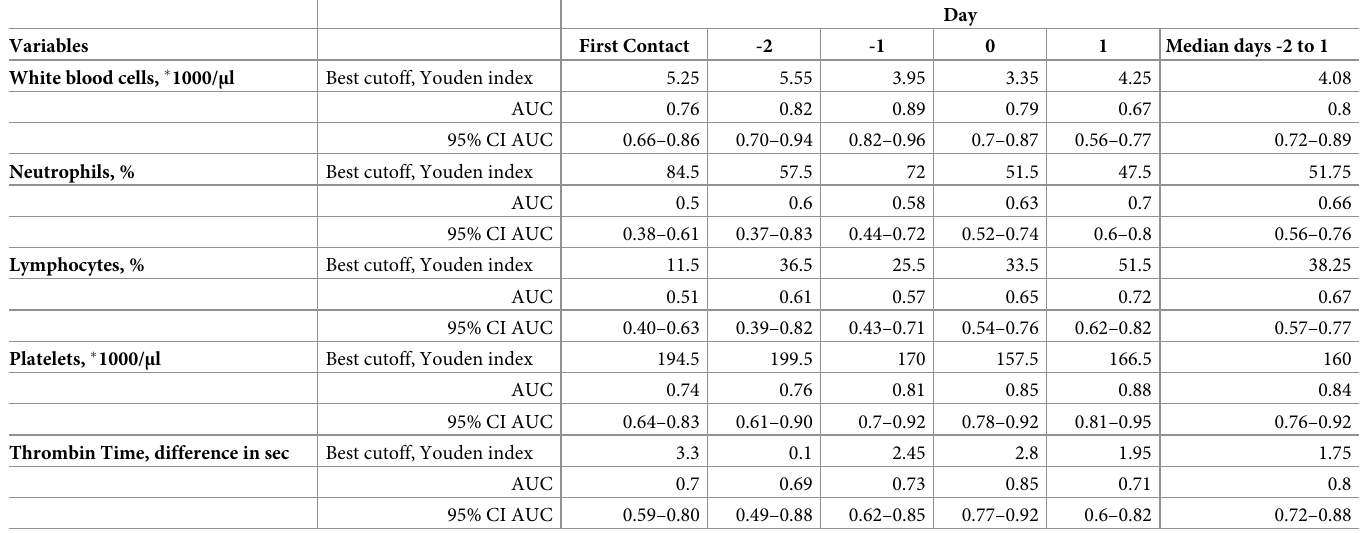
Table 2. Evolution of the receiver operating characteristics statistics for selected biomarkers over the course of disease. Classification between the dengue and OFI groups. First contact: day of first contact with healthcare (independently of the day of fever). Median days -2 to 1: a posteriori calculation of the biomarker’s median value between D-2 and D+1. AUC: area under the curve; CI: confidence